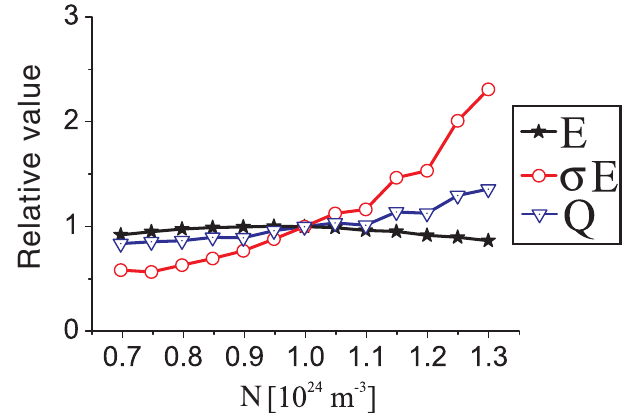
FIG. 6. (Color) Effect of fluctuations in the plasma density on the final beam parameters [energy ( E ), energy spread ( (cid:5)E ), and trapped fraction ( Q )] for a laser of a 0 ¼ 0 : 32 (c) with injection 300 fs behind the laser pulse.